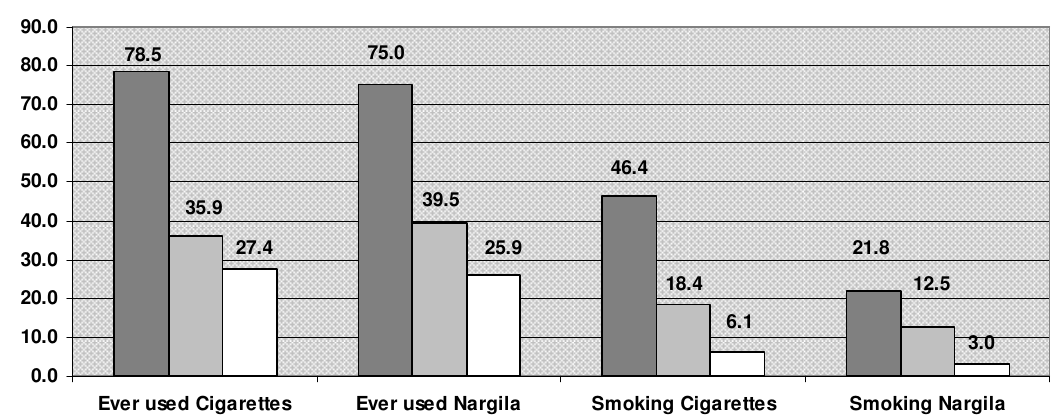
FIGURE 1. Bar graph representation of the percentage of students that smoke cigarettes and nargila by religious conviction; p < 0.001 for the four time reference, n = 326.